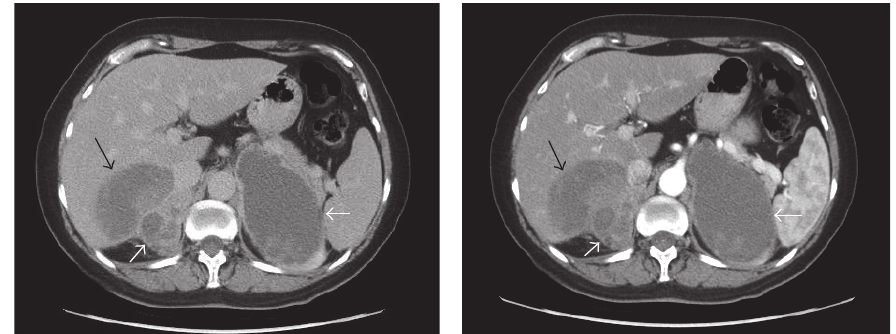
Figure 1: Computed tomography (CT) of abdomen; cystic masses replacing both adrenal glands and infiltrating liver can be seen (arrows).